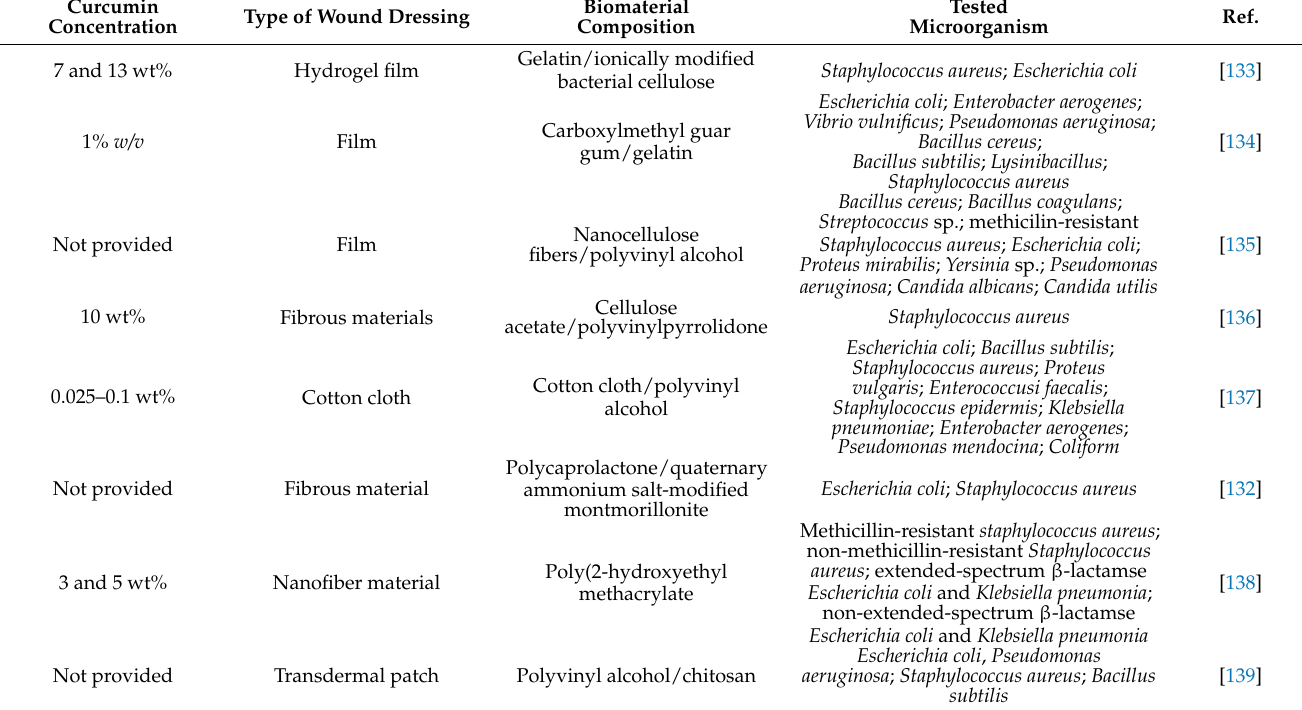
Table 9. Antimicrobial curcumin-loaded biomaterials for wound healing